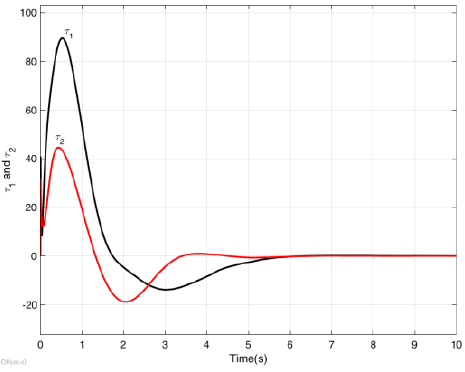
Figure 5. Torque